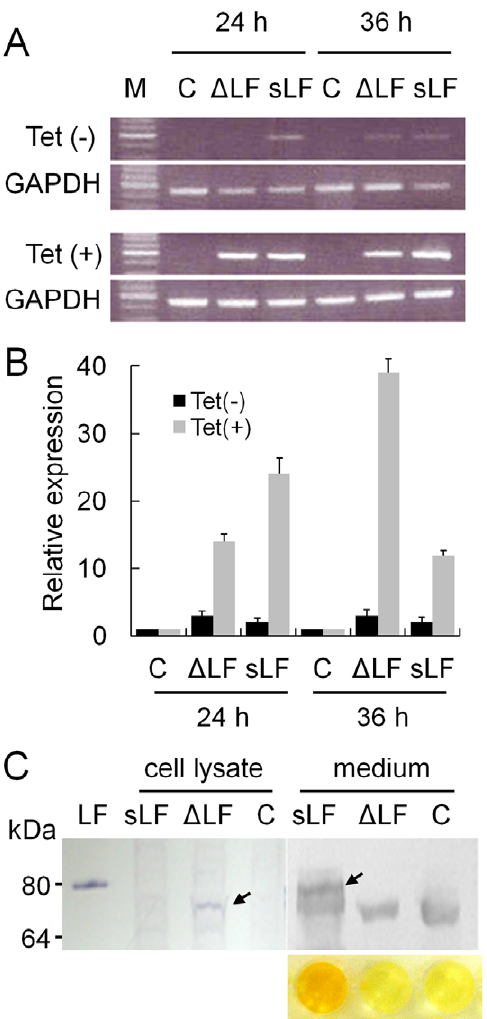
Figure 1. Overexpression of human LF in HEK293 cells using Flp-In T-Rex system. (A) End-point RT-PCR analysis of LF. RT-PCR was conducted for RNAs from HEK293 cells transfected with T-Rex LF expression vectors with signal sequence (sLF) or without signal sequence and 26 N-terminal amino acid residues ( D LF), non-treated with (Tet( 2 ), top panel) or treated with tetracycline (Tet( + ), bottom panel) for 24 or 36 h. C, vector alone. M, size marker. (B) Real-time RT- PCR analysis of LF. Each reaction per clone was carried out in duplicate, and the average of 15 clones is presented along with the standard error. (C) Immunoblot analysis of LF. LF protein expressed from recombinant vector was immunobloted using anti-LF antibody from cell lysate and culture media. LF, commercially available sLF (80 kDa). C, vector alone. LFs expressed from vectors with and without the signal sequence and 26 N-terminal amino acid residues are marked by arrows. Signals below the LF bands appearing in all samples in the medium are non- specifically-reacted serum proteins. The result of ELISA for the LF in medium is shown at the bottom.